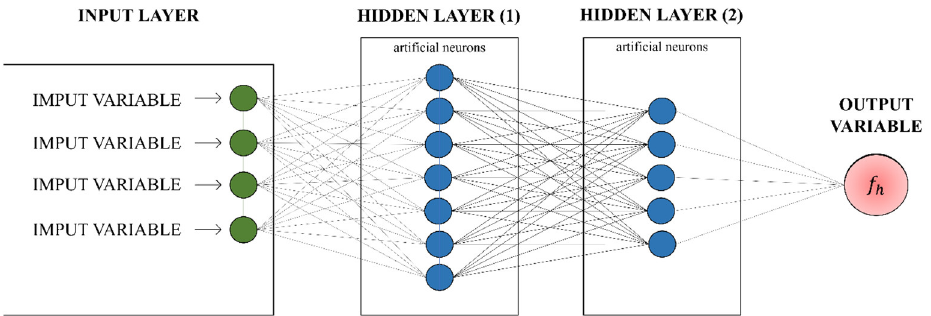
Figure 3. Block diagram of an artificial neural